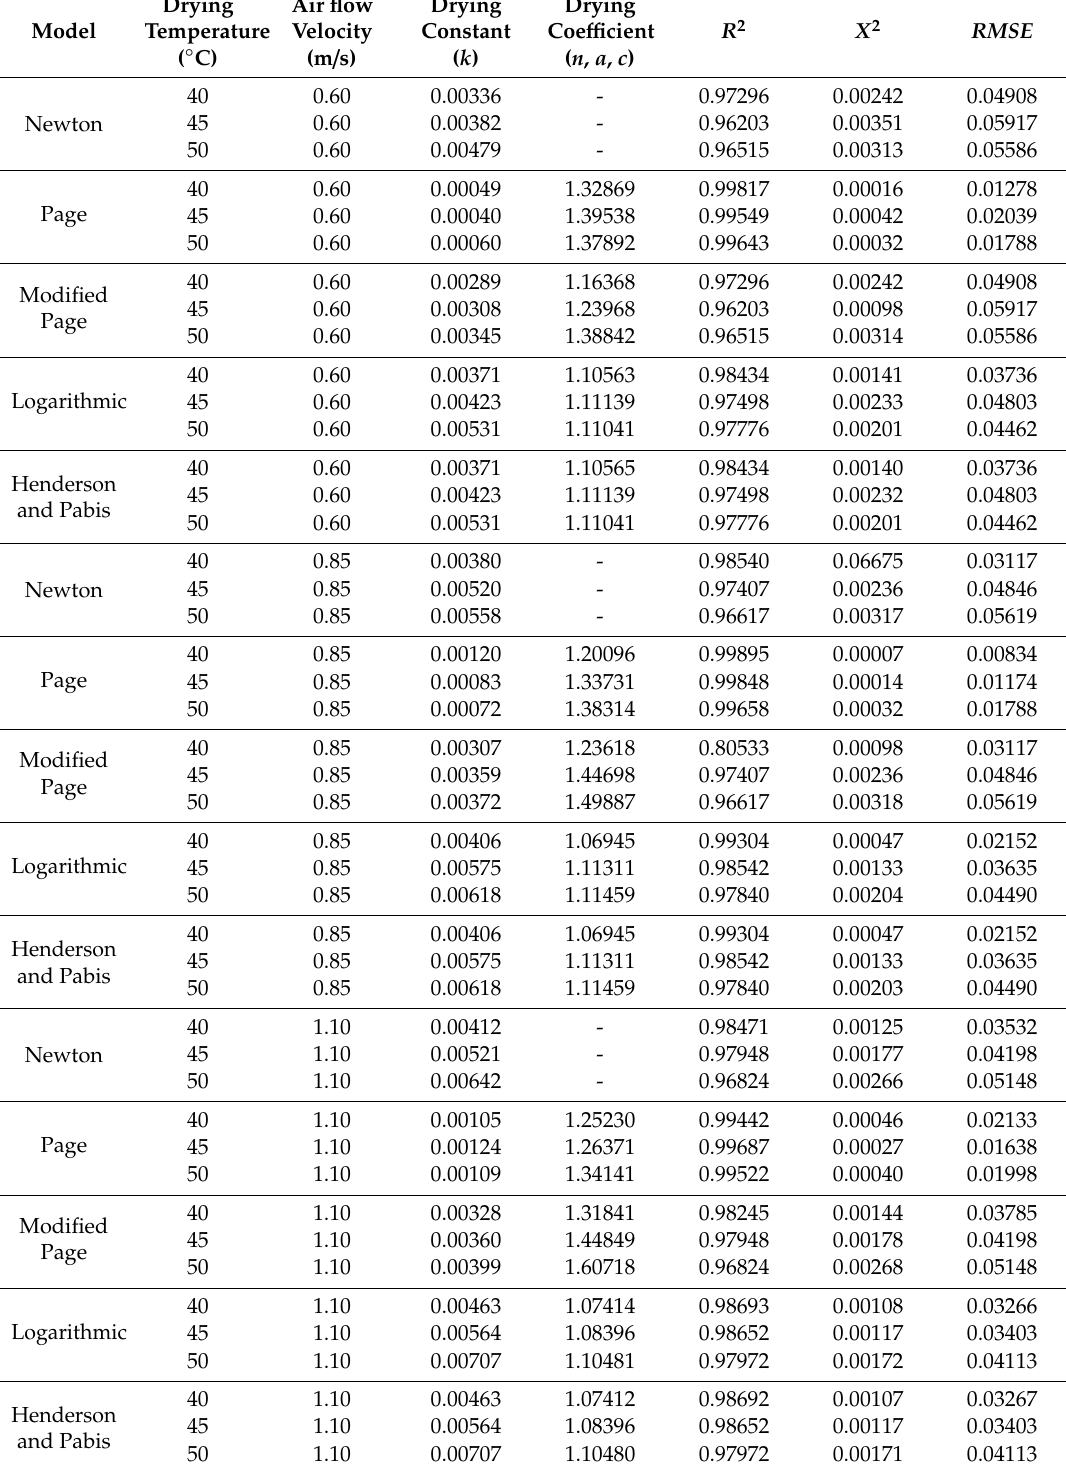
Table 3. Summary of the regression analysis of apple slices with a 6 mm